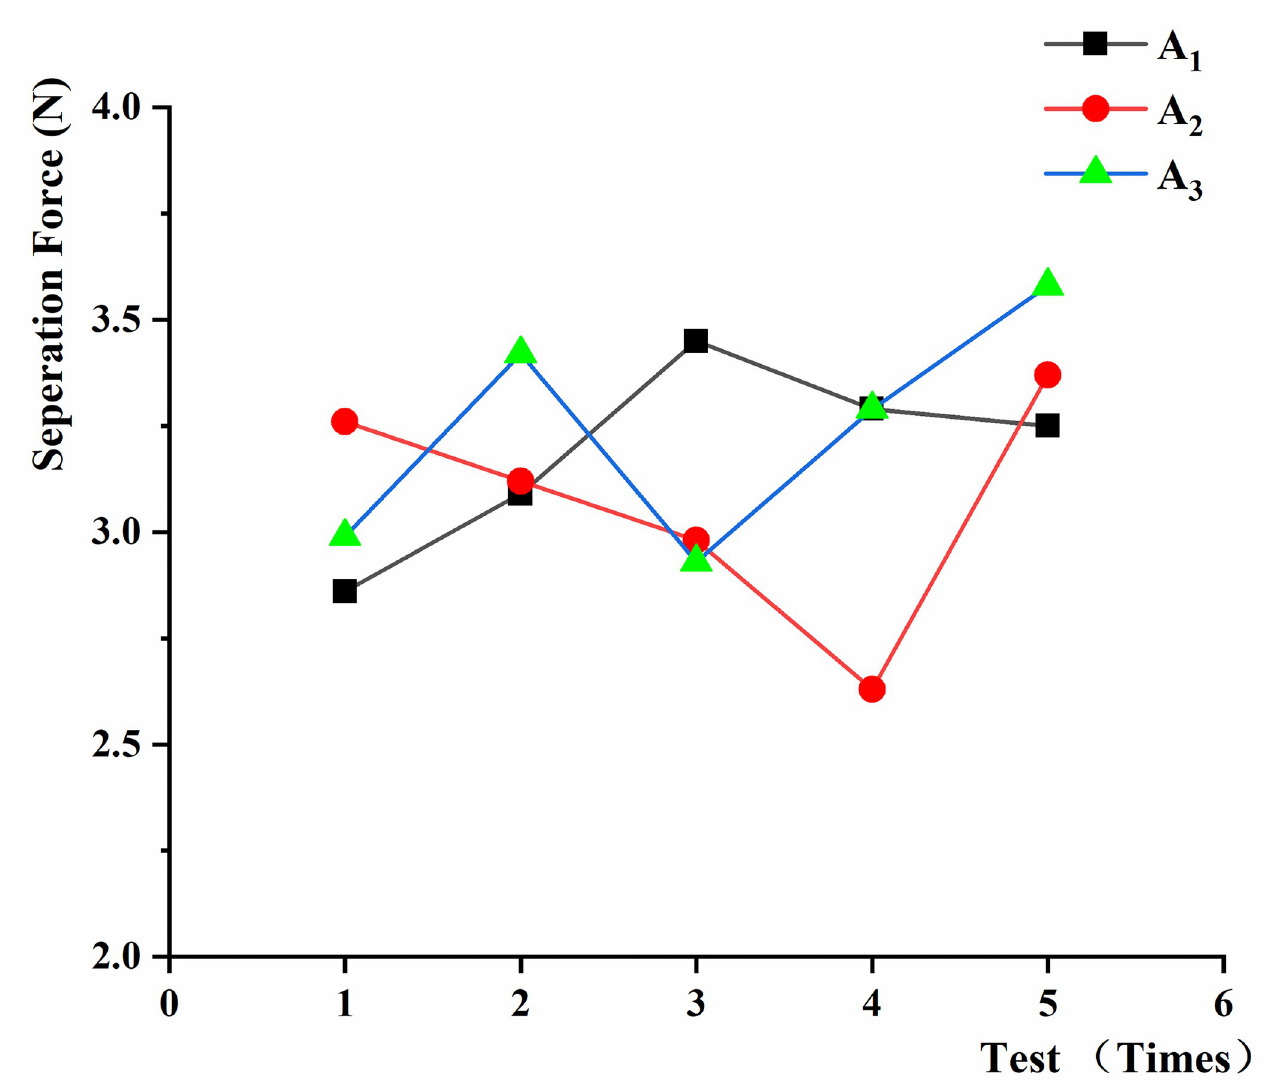
Fig 12. Separation force between black fungus and the sticks at different loading